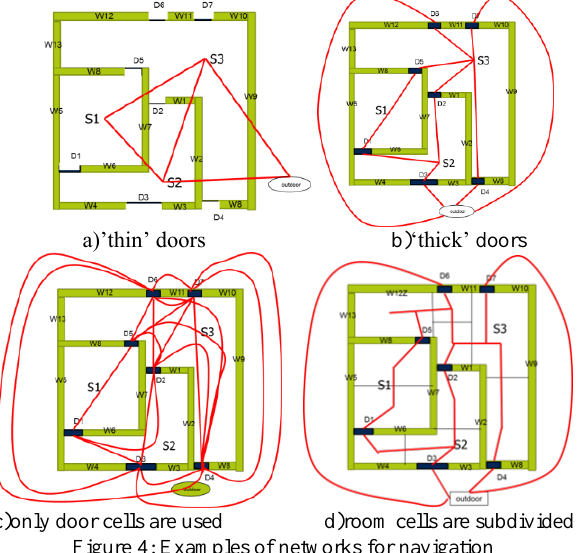
Figure 4: Examples of networks for navigation Clearly, this flexible mechanism to extract a network for navigation by only modifying the cells in the primal space is the most notable characteristic of IndoorGML.